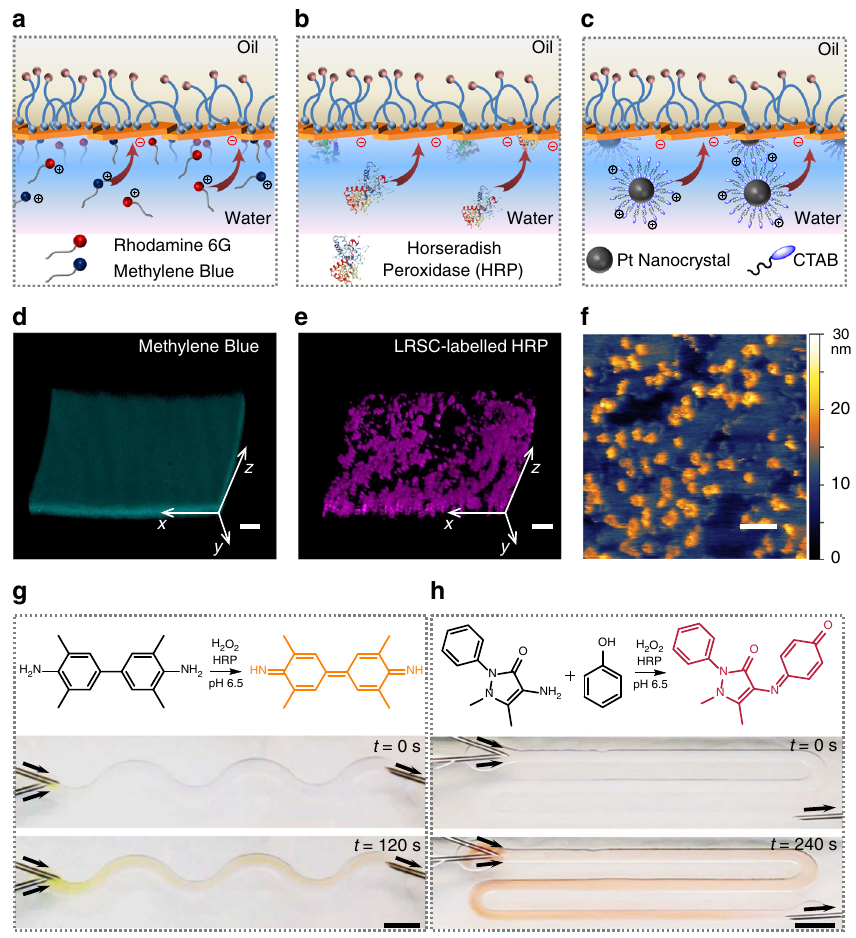
Fig. 3 All-liquid microreactors. a – c Schematic of the anchoring of cationic molecules ( a ), enzymes ( b ), and nanocrystals ( c ) to the anionic NPS fi lm lining the microchannels. d , e 3D reconstitution of confocal images of methylene blue ( d ) and LRSC-labeled HRP ( e ) to determine the adhesion of cationic species to the NPS wall of the microchannel. Scale bars, 100 µ m. f In-situ AFM image of the NPS fi lm immobilized with CTAB-coated Pt nanocrystals at the water − silicone oil interface. Scale bar, 100 nm. g , h Oxidation of TMB ( g ) and 4-AAP/phenol ( h ) substrates catalyzed by immobilized HRP in the channels, which generate products with distinctive colors under fl ow. Scale bars, 5 mm. NPS nanoparticle − polymer surfactant, LRSC lissamine rhodamine B sulfonyl chloride, HRP Horseradish peroxidase, TMB 3,3 ′ ,5,5 ′ -tetramethylbenzidine, 4-AAP